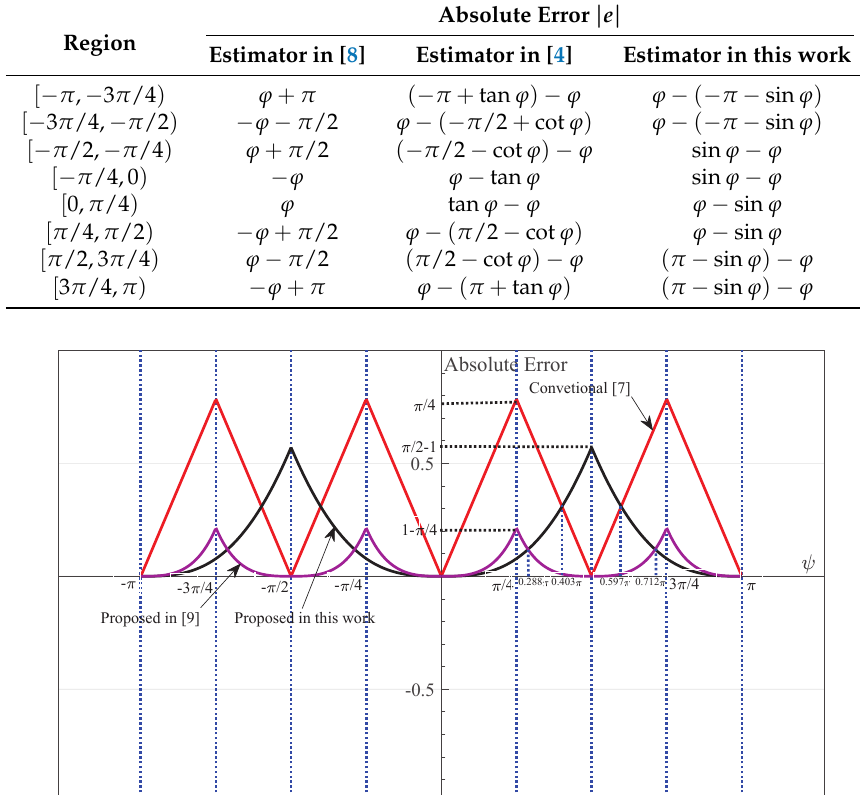
Figure 5. The absolute error | e | of three different estimation